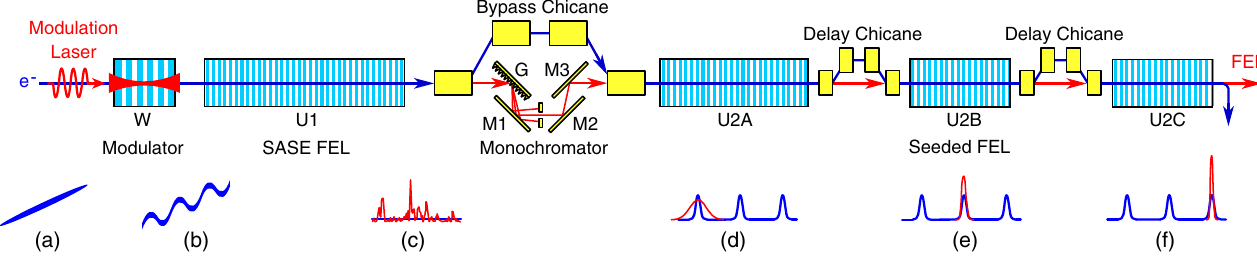
FIG. 1. Layout of the proposed scheme based on a self-seeded FEL configuration (not to scale). A time-energy chirped electron beam (a) is used. A modulator comprising an infrared optical laser and a short wiggler (W) is added to modulate the chirped electron beam (b). The seeded FEL stage consists of three undulator sections (U2A, U2B, and U2C) separated by two delay chicanes. (c), (d), (e), and (f) are sketches of electron current (blue curves) and FEL power (red curves) profiles after U1 and before U2A, U2B, and U2C,